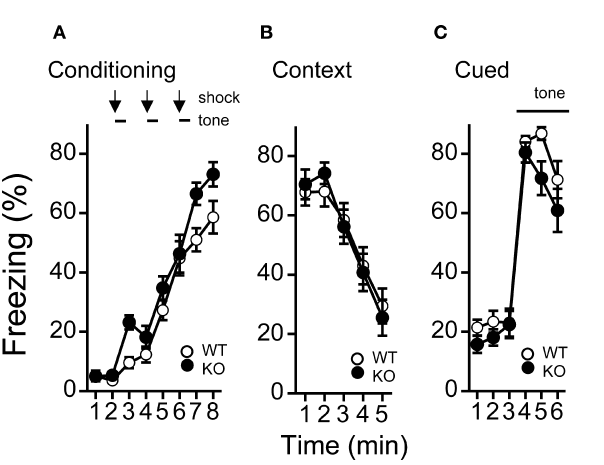
respectively.Figure 8 | Levels of freezing in kf-1 − / − mice during conditioning, cued testing with altered context, and context testing. (A) Immediate freez- = 5.788). (B) Contextual ing during conditioning phase ( p = 0.0211, F 1,38 = 0.0002). (C) testing conducted 1 day after conditioning ( p = 0.9891, F 1,38 = 1.455) and pre-tone period Cued test with altered context ( p = 0.2352, F 1,38 = 3.294) are shown. There were no signifi cant differences ( p = 0.0774, F 1,38 observed between kf-1 + / + and kf-1 − / − mice in contextual and cued fear con- ditioning test, although signifi cant difference was observed in the immediate freezing without conditioning (see Section ‘Contextual and cued fear condi- tioning’). WT and KO stand for kf-1 + / + and kf-1 − / − mice, Figure 10 | Performance of kf-1 − / − mice in the elevated plus maze test. At the start of the test, mice were placed individually in the crossing center from open and closed arms. Data are given as mean ( ± SEM). (A) Number of entries into the center crossing between open and closed arms. (B) Total distance (centimeters) traveled. (C) % Number of entries into open arms. (D) % Time spent on open arms. Note that the closed arms were enclosed at both sides by transparent walls, and therefore mice could recognize visibly their posi- tion on heights even on the closed arms. ** p < 0.005; *** p < 0.0005 (see Section ‘Elevated plus maze test’). WT and KO stand for kf-1 + / + and kf-1 − / − mice,